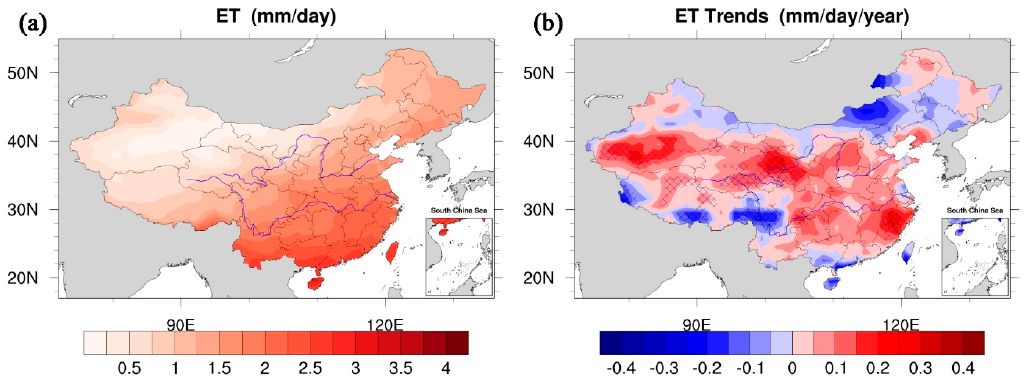
Figure 2. Distributions of the mean annual land ET ( a ) and the ET MK (Mann–Kendall) trend ( b ) in China from 1989 to 2005. Blue is negative, and red is positive. The grid lines indicate that the 95% significance test is passed.